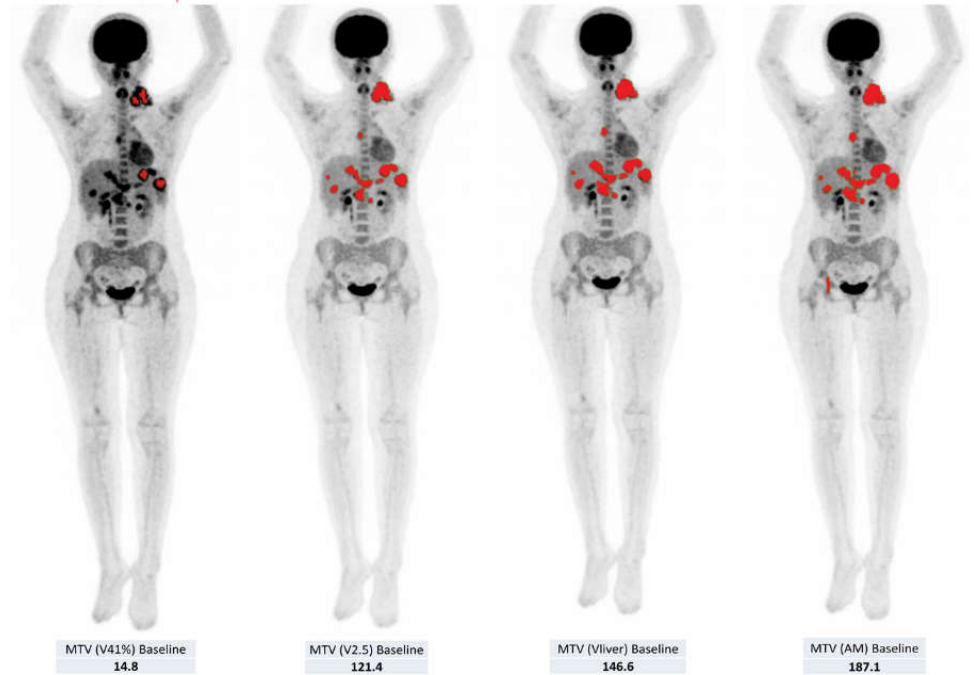
Figure 1. MIP (maximal intensity projection) image illustration of the four segmentation techniques applied in our study. From left to right: fixed 41% threshold (V41%), fixed absolute SUV threshold of 2.5 (V2.5), SUVmax(lesion)/SUVmean liver >1.5 (Vliver) and adaptive method (AM). Corresponding MTV (metabolic tumor volumes) at baseline are shown beneath each MIP image. The areas highlighted in red in the figures indicate the contours of the malignant lesions delineated by each segmentation technique.